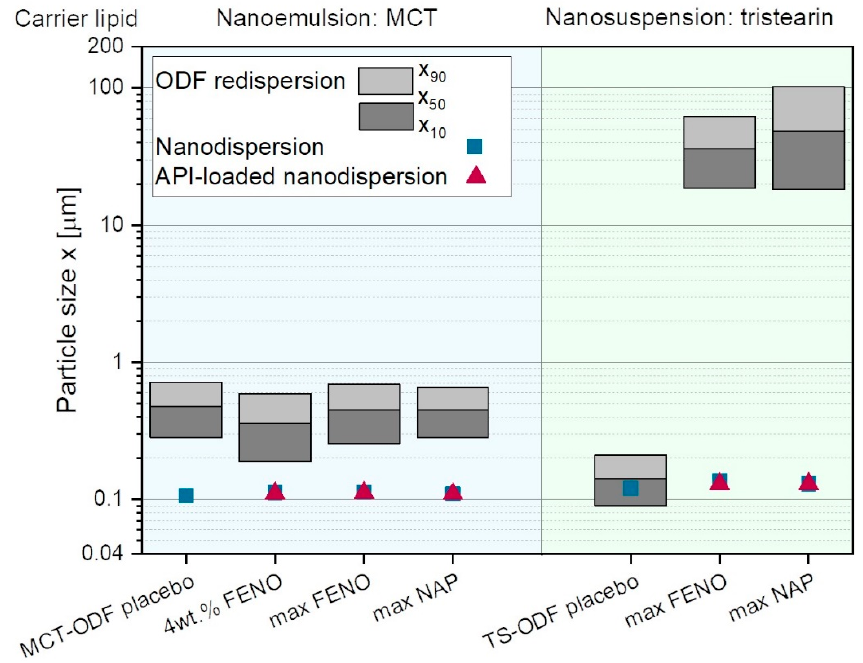
Figure 5. Particle sizes after redispersion of ODFs loaded with FENO and NAP containing MCT emulsion and tristearin suspension as well as API-free (square) and API-loaded (triangle) lipid dispersions (“MCT-ODF placebo” for nanoemulsion and “TS-ODF placebo” for nanosuspension).